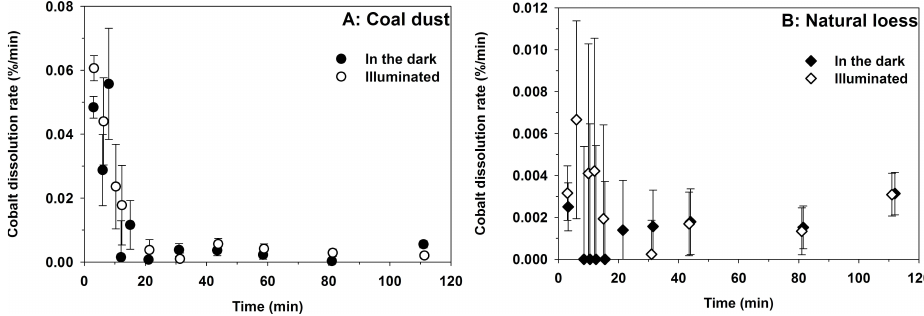
Fig. 2. Dissolution rates of cobalt (%/min) for anthropogenic (A) and natural (B) dust expressed as function of time.